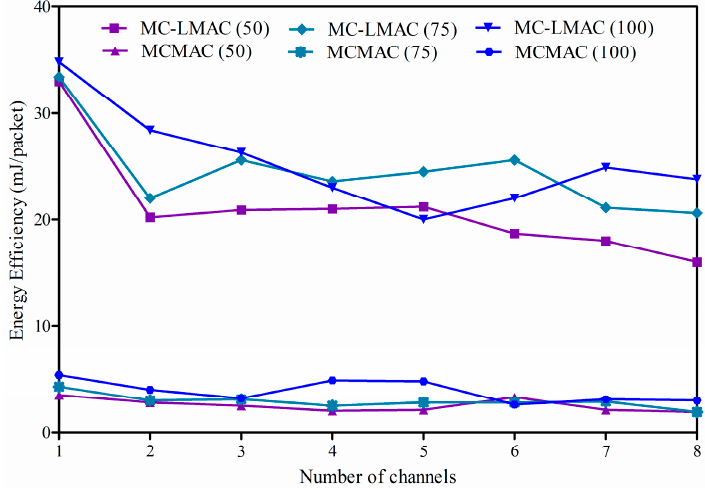
Figure 11. Network throughput according to the number of channels and network